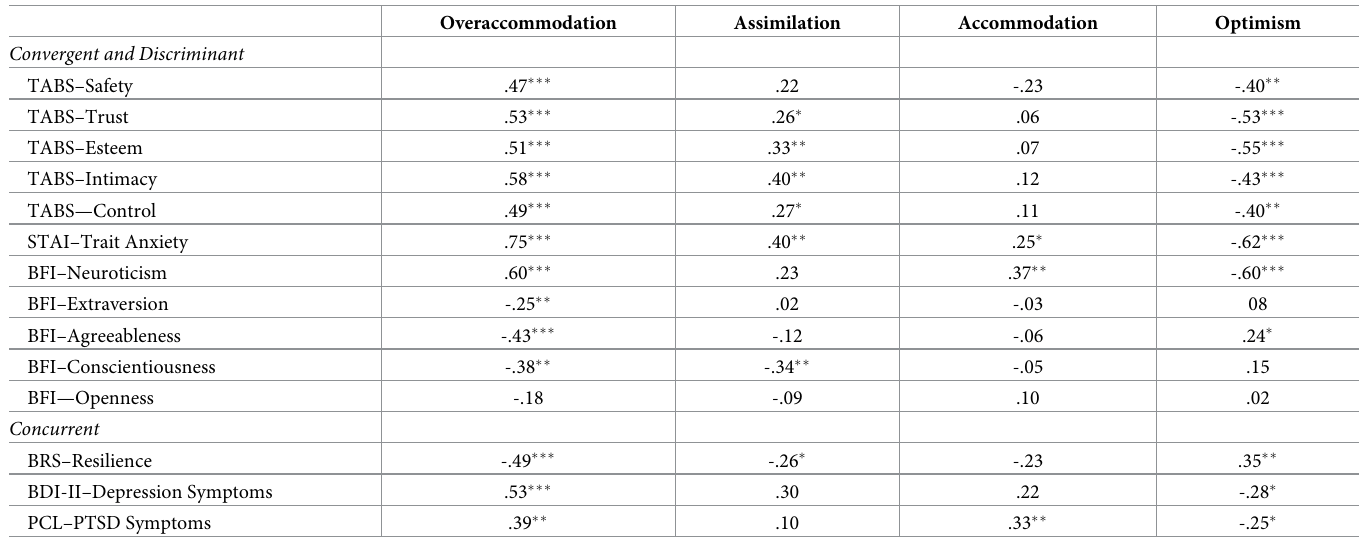
Table 7. Evidence of criterion-related validity: Phase 4 sample ( N =